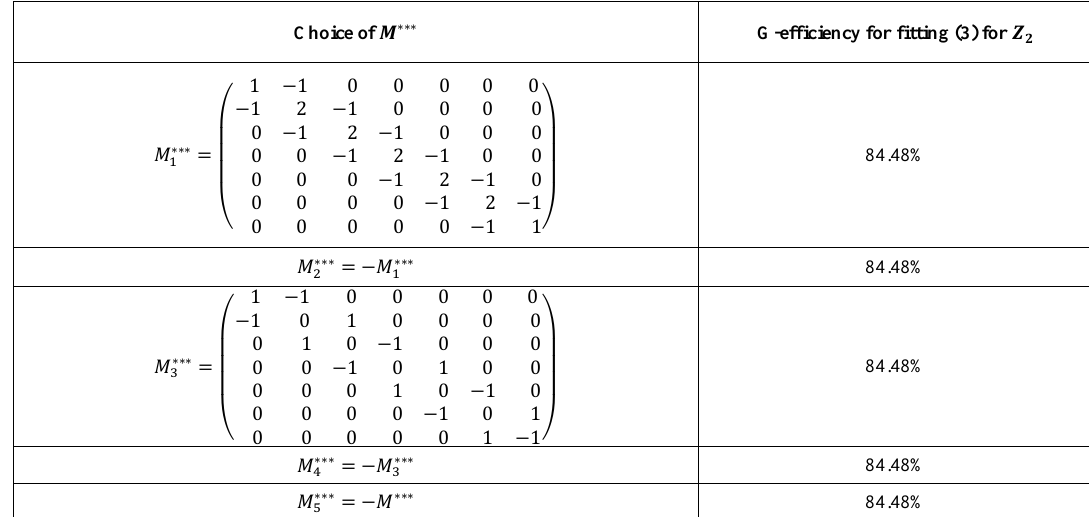
Table 4. G-efficiency of unconstrained mixture designs corresponding to different choices of 𝑀 ∗∗∗ for fitting Scheffé’s linear model Choice of 𝑴 ∗∗∗ G-efficiency for fitting (3) for 𝒁 𝟐